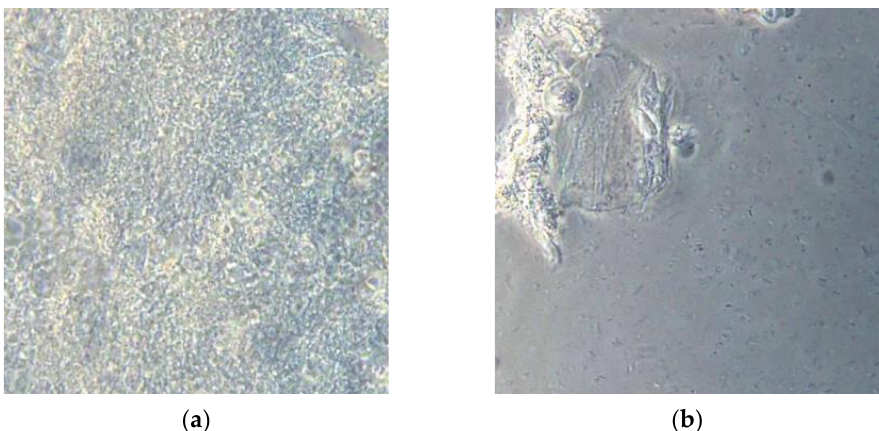
Figure 3. Subgingival plaque images observed under a phase contrast microscope at T 1 : ( a ) Non- pathogenic bacterial flora (patient belonging to Group A); ( b ) Pathogenic bacterial flora (patient belonging to Group B).